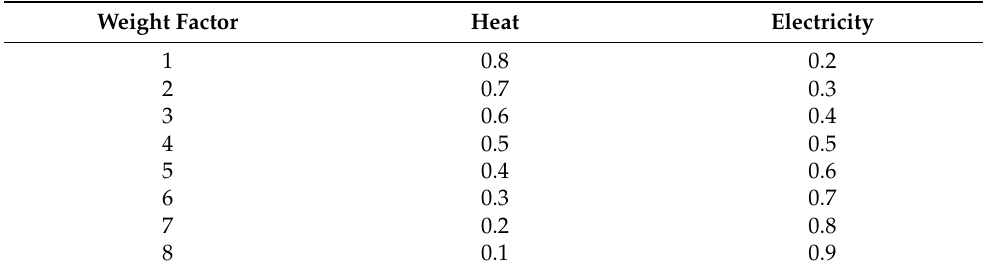
Table 4. Weight factors for the multi-objective function. Weight